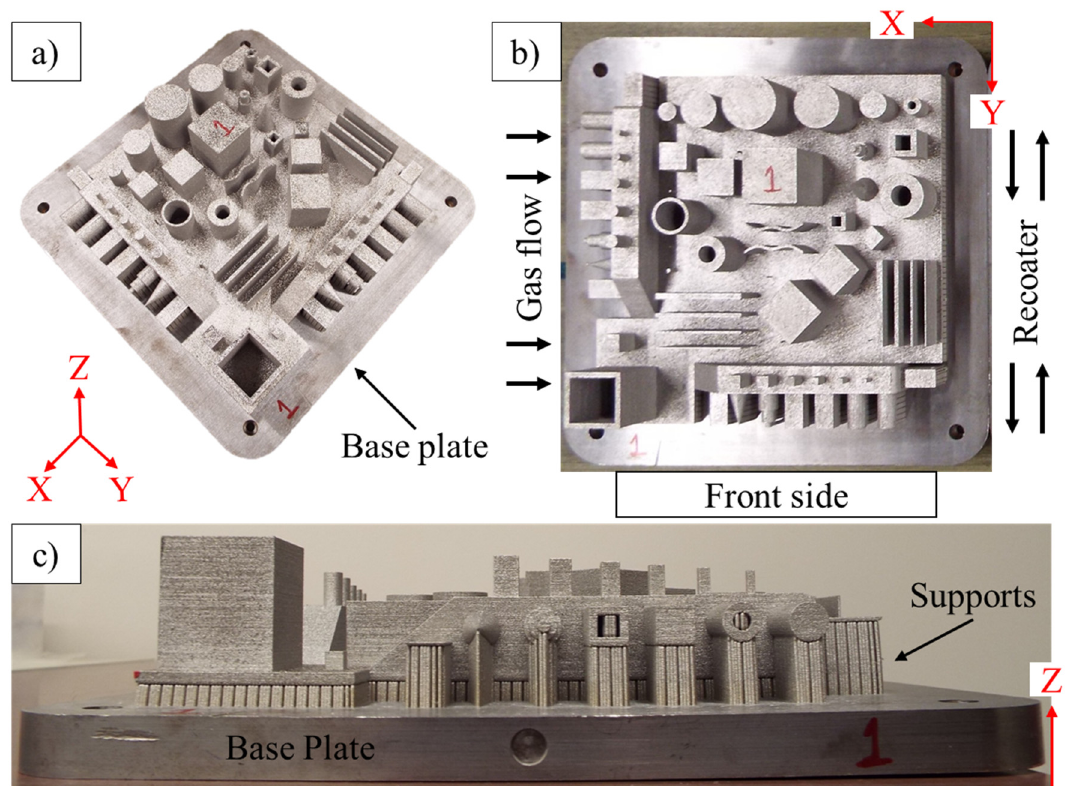
Figure 2. Example of manufactured sample: ( a ) Isometric view of the GBTA, ( b ) top view of the manufactured GBTA showing the “front side” of the LPBF system, gas flow direction, and recoater direction, and ( c ) side view of the manufactured GBTA showing the depicting and the base plate.